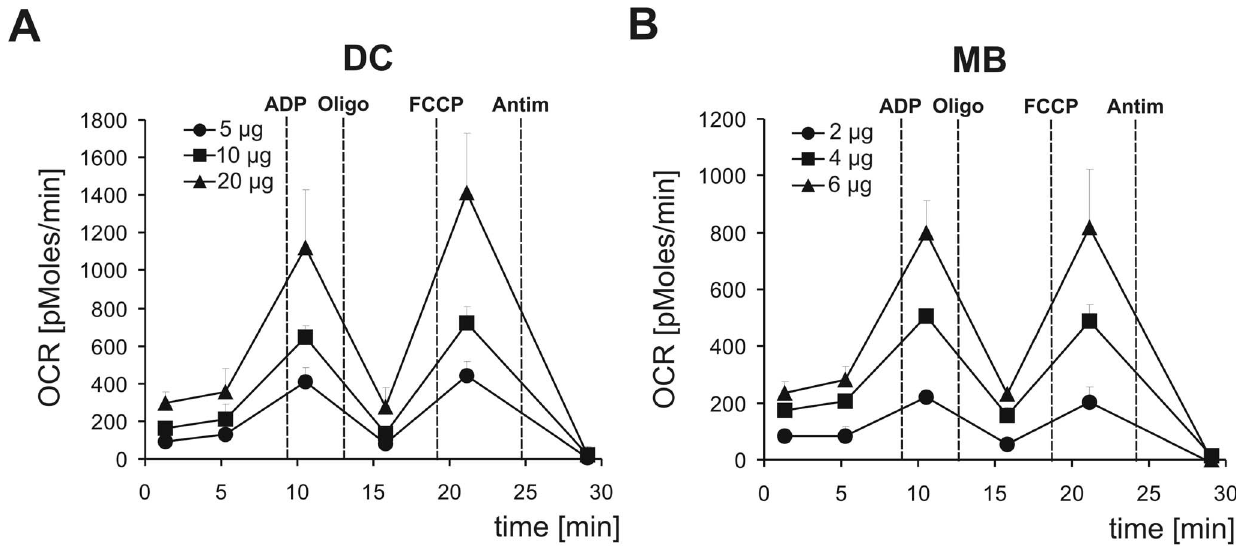
Figure 5. Liver mitochondria isolated by magnetic beads have higher oxygen consumption rates than mitochondria isolated by differential centrifugation. Oxygen consumption rates (OCRs) were determined using an XF24 Extracellular Flux Analyzer with the given amount of freshly isolated mitochondria ( m g/well), which were purified by A DC or B MB methods. Briefly, succinate was used as a substrate to feed electrons to complex II and basal (state II) respiration was measured. State III respiration was determined in the presence of ADP. Oligomycin (Oligo) addition blocked ATP synthase and so evoked state IVo respiration. Maximum respiration (state uncoupled) was measured in the presence of the uncoupler FCCP. Finally, Antimycin A (Antim) was given to inhibit complex III. Data are represented as means of three independent experiments (5–8 replicates per groups) 6 SD.